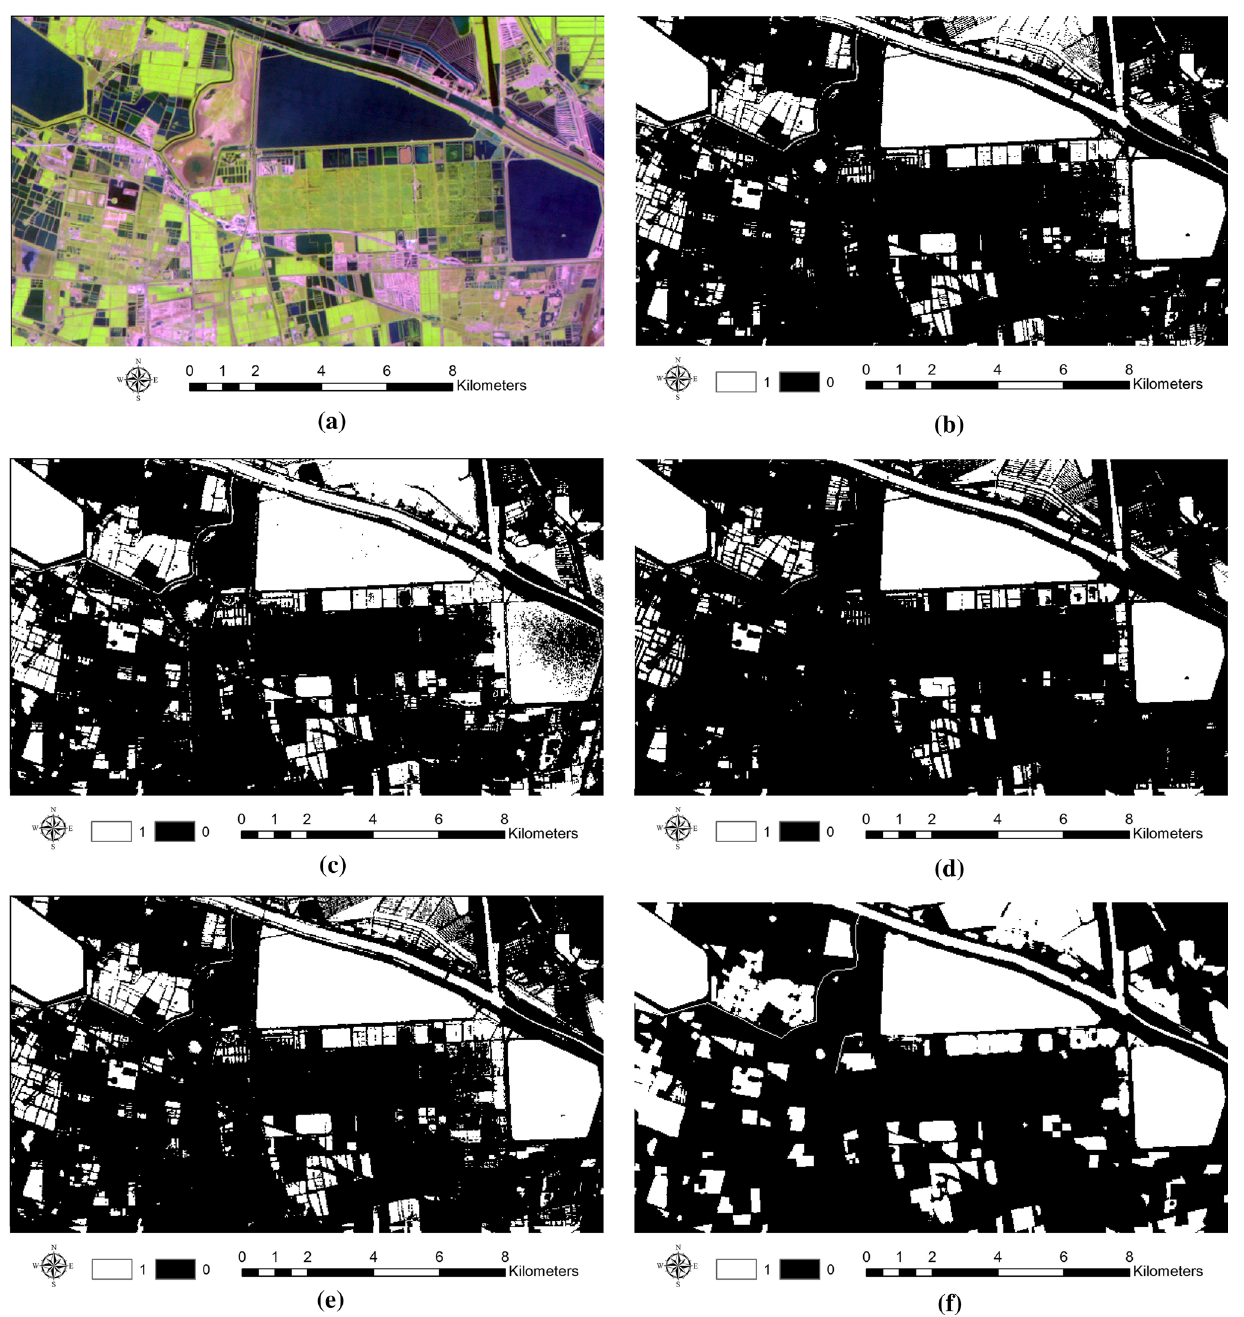
Fig. 7 Image and water change extraction results of the test area: a TM image; b single-band threshold; c multi-band spectral relationship; d ISODATA; e MNDWI; f MNDWI-based adaptive dynamic threshold